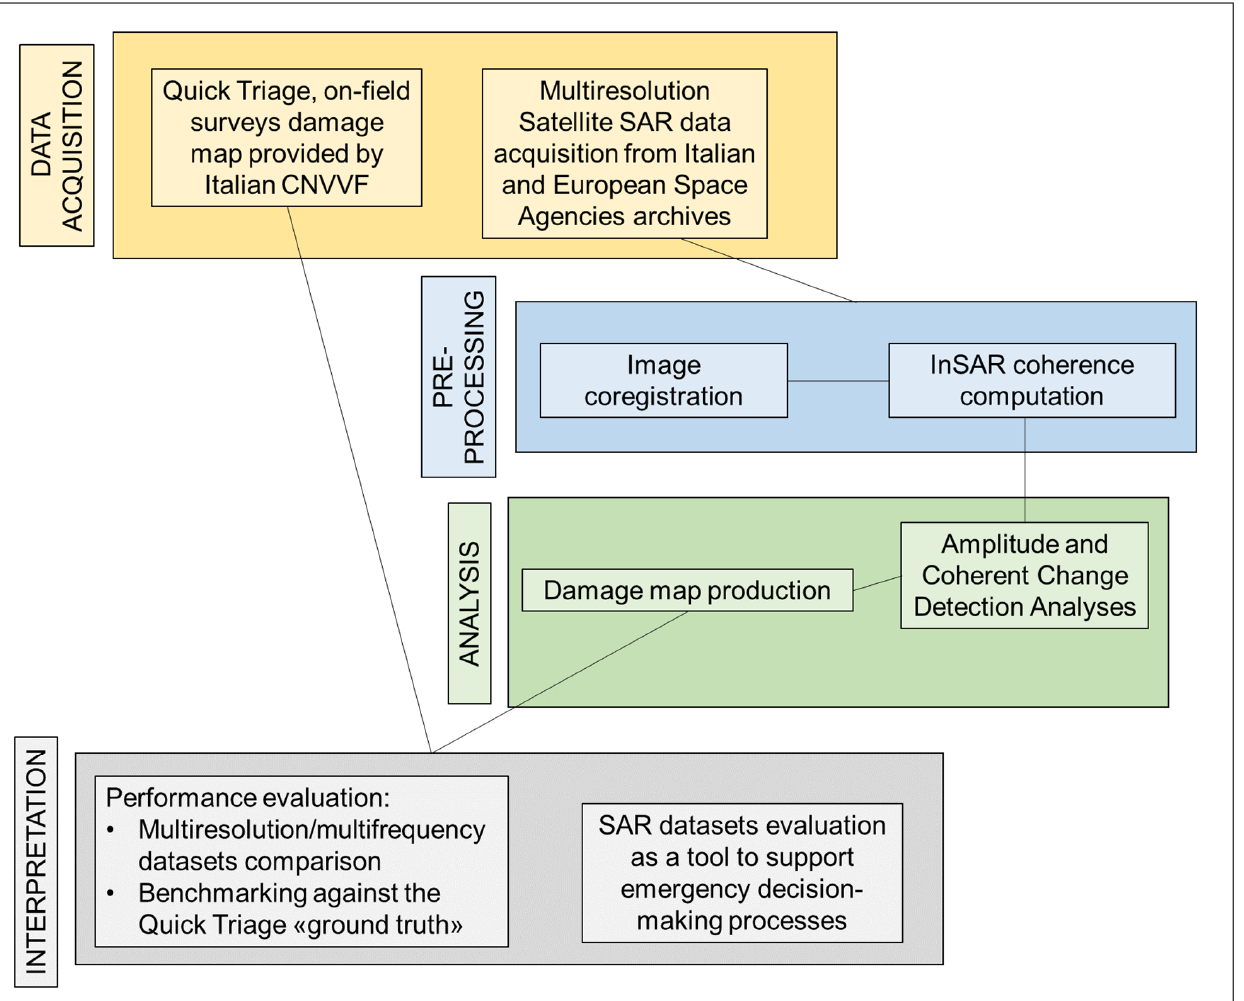
Figure 1. Workflow of the approach carried out to evaluate the performance of Multi-resolution Satellite SAR Images for Post-Earthquake Damage Detection and Mapping.